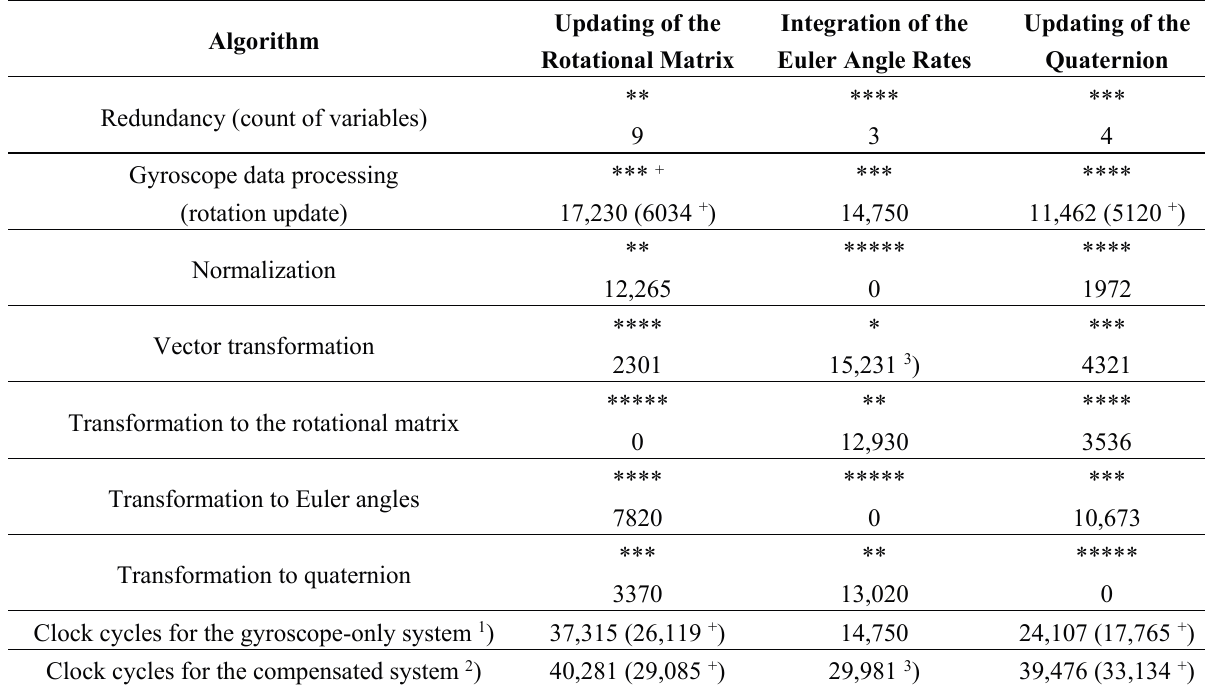
Table 1. Comparison of methods in terms of 8-bit AVR processor clock cycles. Algorithm